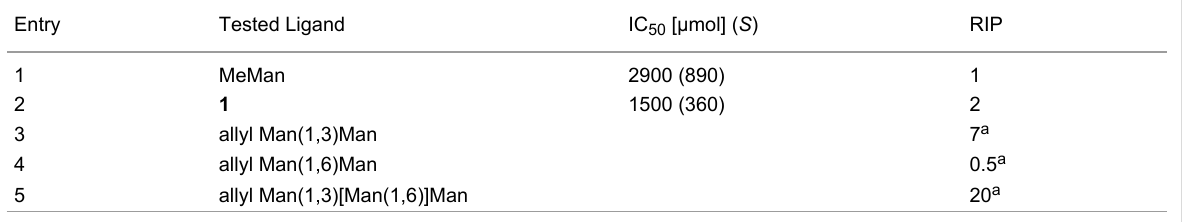
Table 1: Inhibitory potencies in mannose-specific E. coli adhesion of the bivalent glycopeptide 1 in comparison with reference ligands, as determined by ELISA. IC 50 -values are average values from three independent assays. S : standard deviation; RIP: relative inhibitory potency based on methyl α -D-mannopyranoside (MeMan) with IP(MeMan) ≡